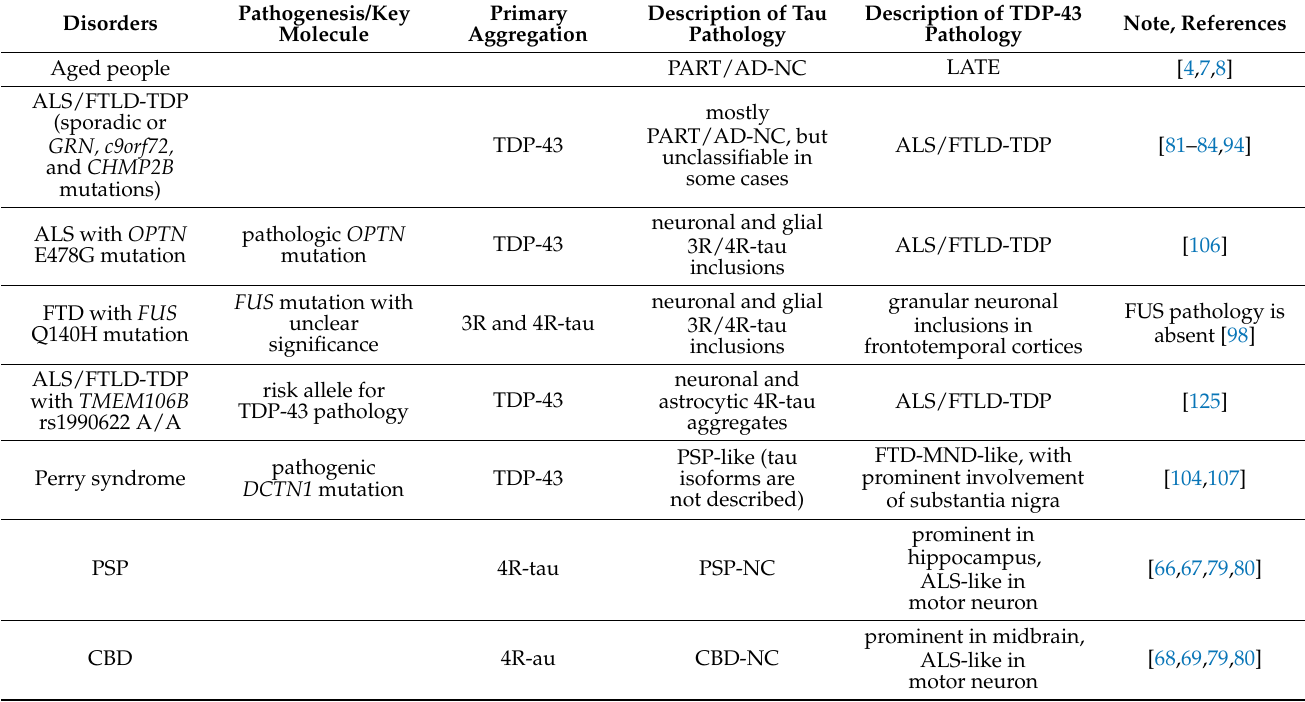
Table 1. Various conditions associated with comorbidity of combined TDP-43 and tau